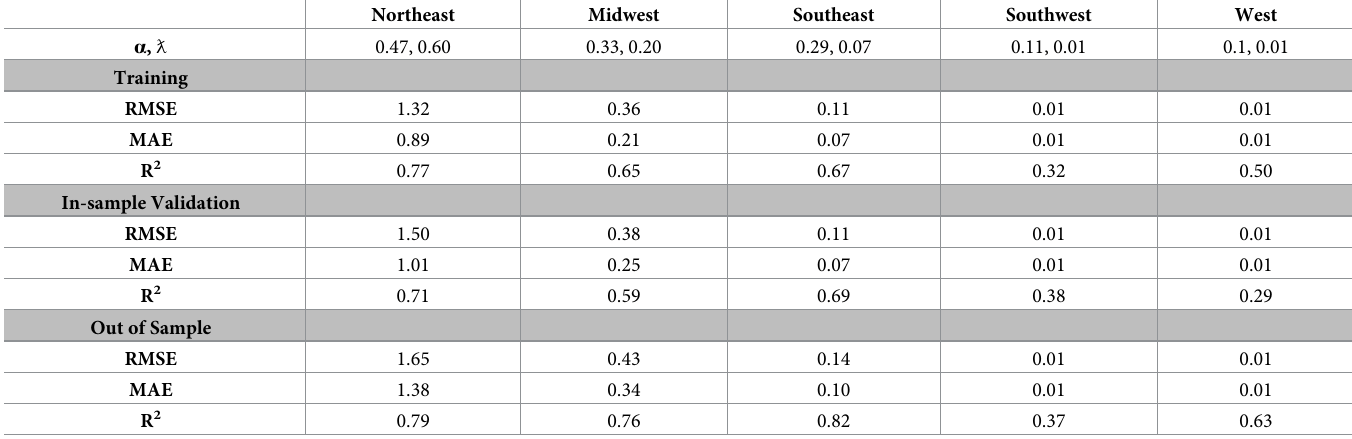
Table 5. Predictions from symptoms and vector terms only models produce accurate predictions with low error. Northeast Midwest Southeast Southwest West 0.47,